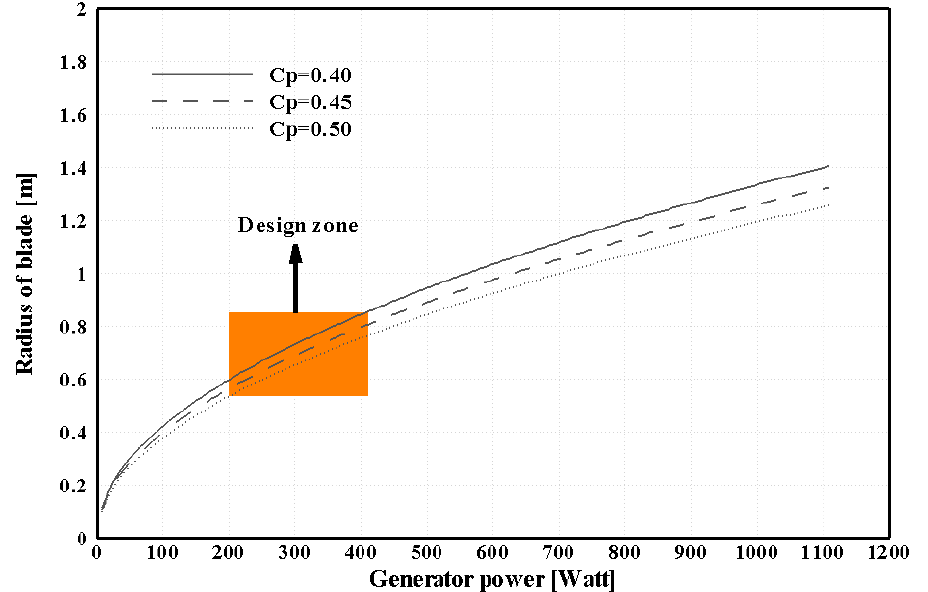
Figure 7. Distributions of r the blade radius with the generator power at the power coefficient (Cp) of 0.40, 0.45, 0.50.